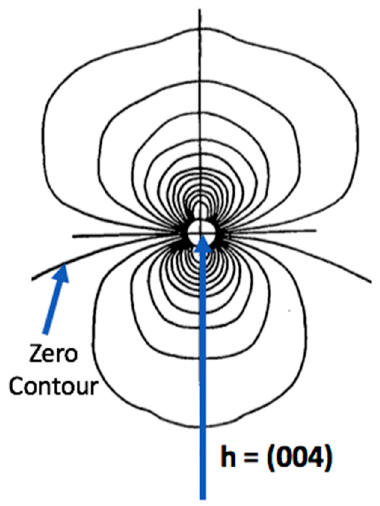
Figure 1. Calculated diffuse scattering contours near a (004) reciprocal lattice point for a point defect with a spherically symmetric displacement field. Adapted from Figure 4 in Reference [10] with permission.